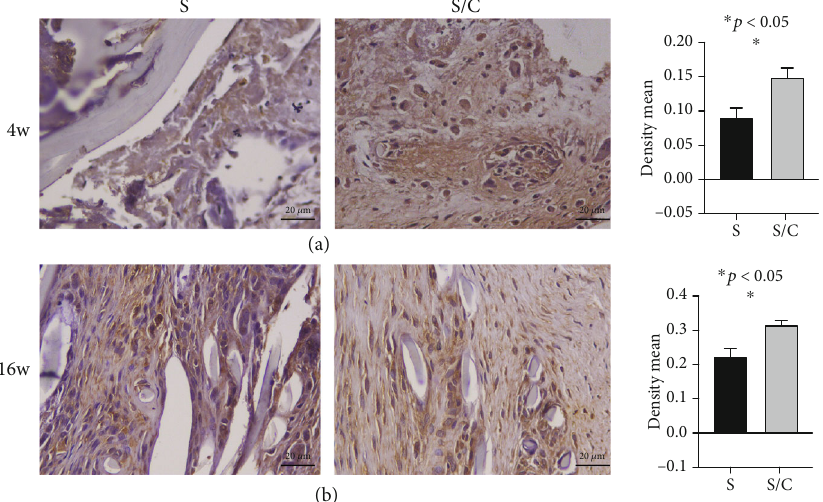
Figure 6: Immunohistochemistry staining of grafts in the knee cavity speci fi c for tenascin-C in the S group and S/C group to assess ligament regeneration: the density mean of immunoreactivity was higher in the S/C group than in the S group at 4 weeks (a) and 16 weeks (b) after the